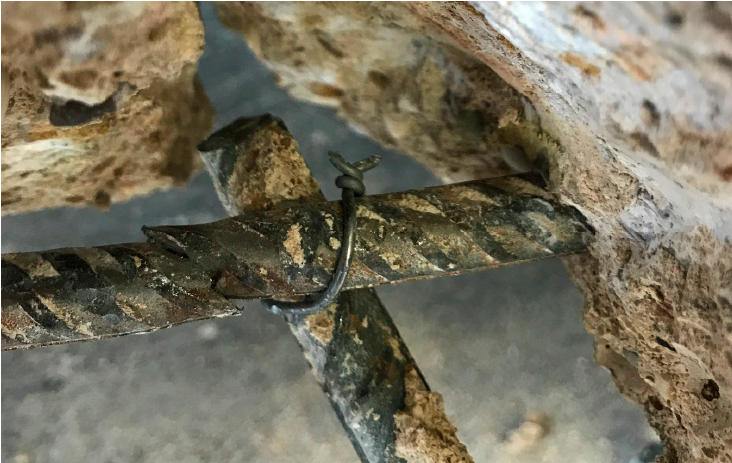
Figure 14. Plastic deformation of flexural tensile steel reinforcement in the cantilever section of S6 (photo by IMB, RWTH Aachen University).